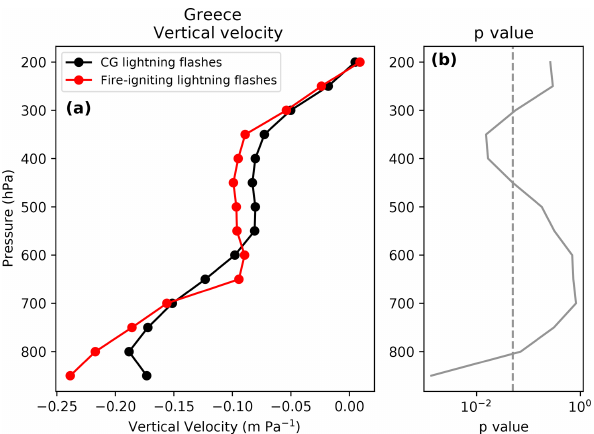
Figure 11. Median vertical velocity profile for the CG lightning and the fire-igniting lightning climatologies in Greece between May and September for the period between 2017 and 2019 (a) . The p value (solid line), representing the probability of equal median between both distributions, and the mark showing the limit at 0.05 (dashed line) are shown (b) .